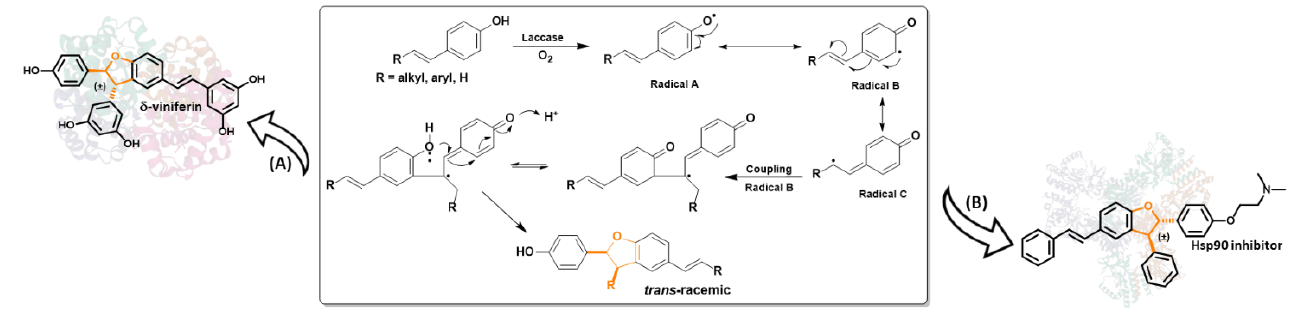
Figure 1. T. versicolor laccase-mediated domino process to 2,3-DHBs via a formal oxidative homo- coupling. Examples of preparations of bioactive compounds: ( A ) δ -viniferin, a natural antioxidant able to bind to human hemoglobin [34] and ( B ) synthetic inhibitor of Hsp90 variants potentially endowed with antiproliferative activity [31].